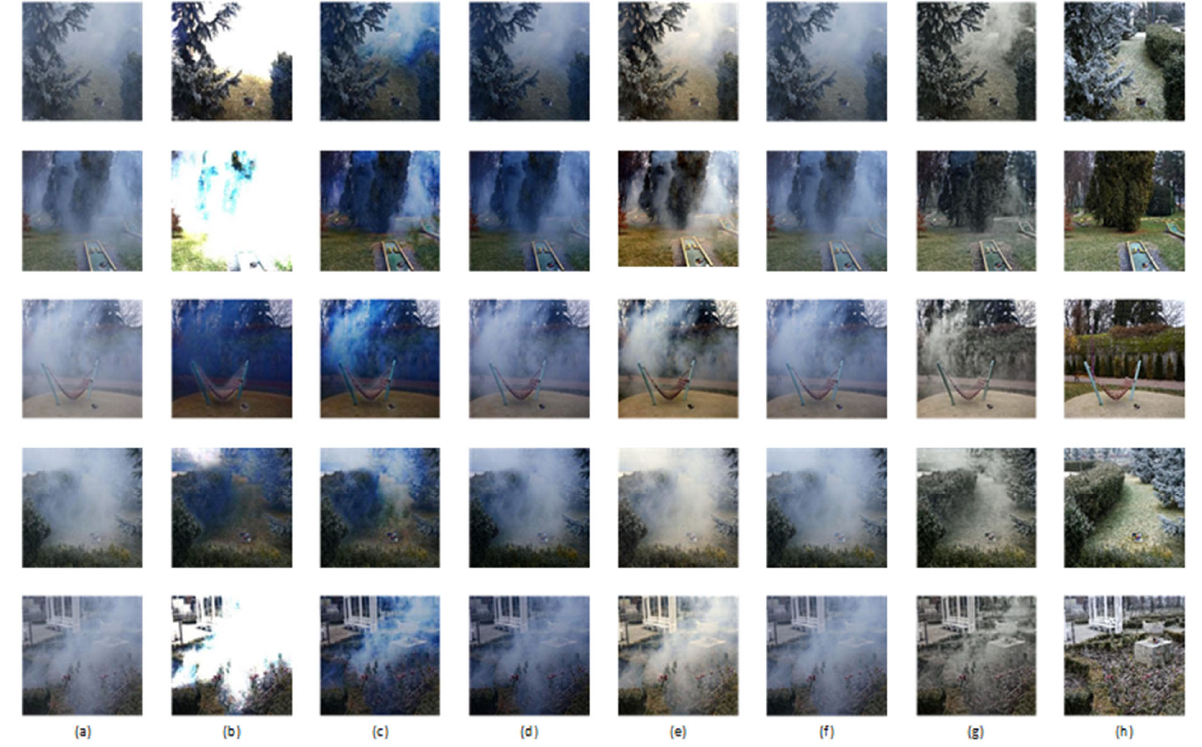
Figure 6. The experimental results of synthesizing inhomogeneous hazy images. ( a ) Hazy image; ( b ) method in [5]; ( c ) method in [6]; ( d ) method in [11]; ( e ) method in [12]; ( f ) method in [15]; ( g ) proposed method; ( h ) standard haze ‐ free image. Table 2. The quantitative evaluation of different defogging methods on the NTIRE2020 ‐ Dhaze dataset.